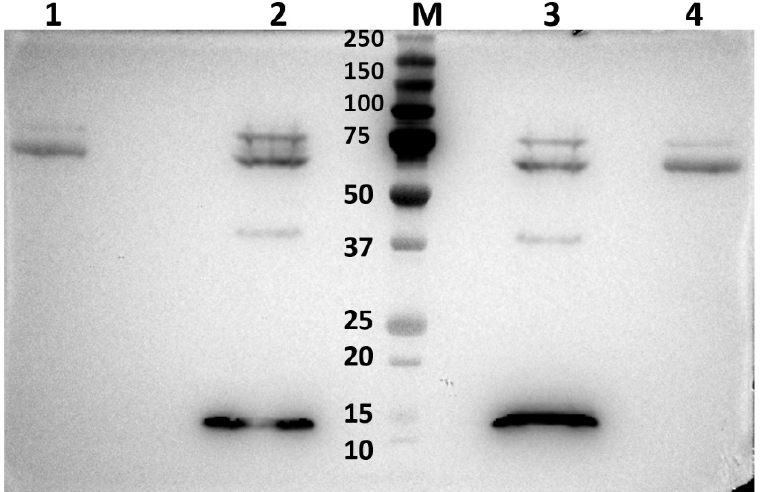
Figure 12. Detection of NS5-6xHis and ZBP1 by Western blo tt ing in protein complexes pulled from BSR cell lysates expressing NS5-6xHis. Lanes 1 and 4 show Western blots of products pulled from lysates of non-transfected BSR cells. Lane 2: contains products pulled from lysates of BSR cells ex- pressing BTV-1 NS5-6xHis (transfected with plasmid pCI-BTV1NS5-6xHis). Lane 3: products pulled from lysates of BSR cells expressing AHSV-4 NS5-6xHis (transfected with plasmid pCI-AHSVNS5- 6xHis). In each case, protein complexes were pulled down using Dynabeads as described in mate- rials and methods, which were then analysed by Western blo tt ing using anti-his-tag antibodies and anti-ZBP1 antibodies. Protein bands that migrated in appropriate positions for NS5-6xHis (~15 KDa), and ZBP1 (~40 KDa), were detected in both lanes 2 and 3, indicating an association of these proteins in the transfected cell. Non-speci fi c bands having sizes of about 65 and 75 kDa were also detected in non-transfected cells in lanes 1–4. These non-speci fi c bands can be observed in Western blots of BSR lysates, both mock-transfected and transfected with pCI-BTV1NS5-6xHis (Figure S17).